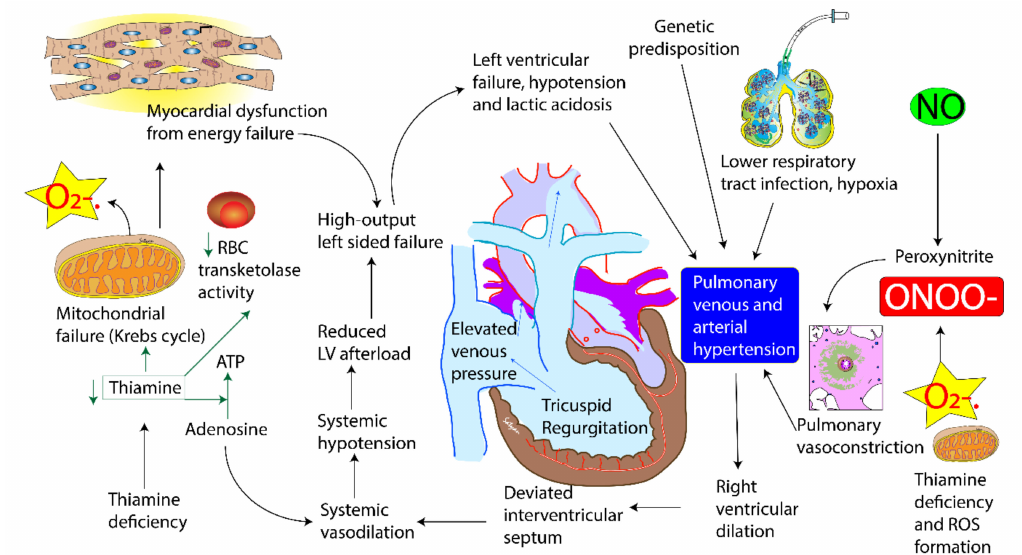
Figure 4. Pathophysiology of thiamine deficiency and pulmonary hypertension of early infancy. (copyright Satyan